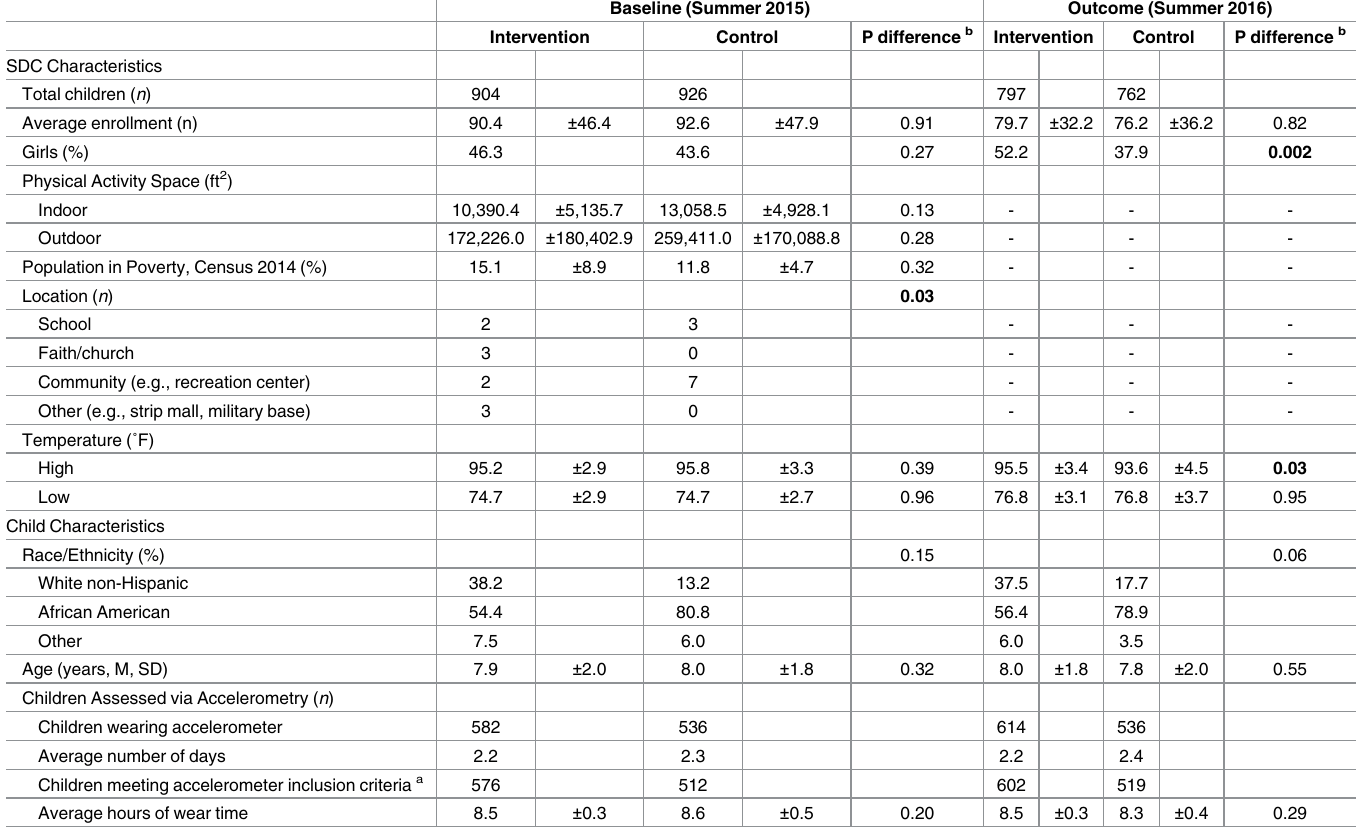
Table 1. Characteristics of participating summer day camps (SDCs) and children by intervention and control at